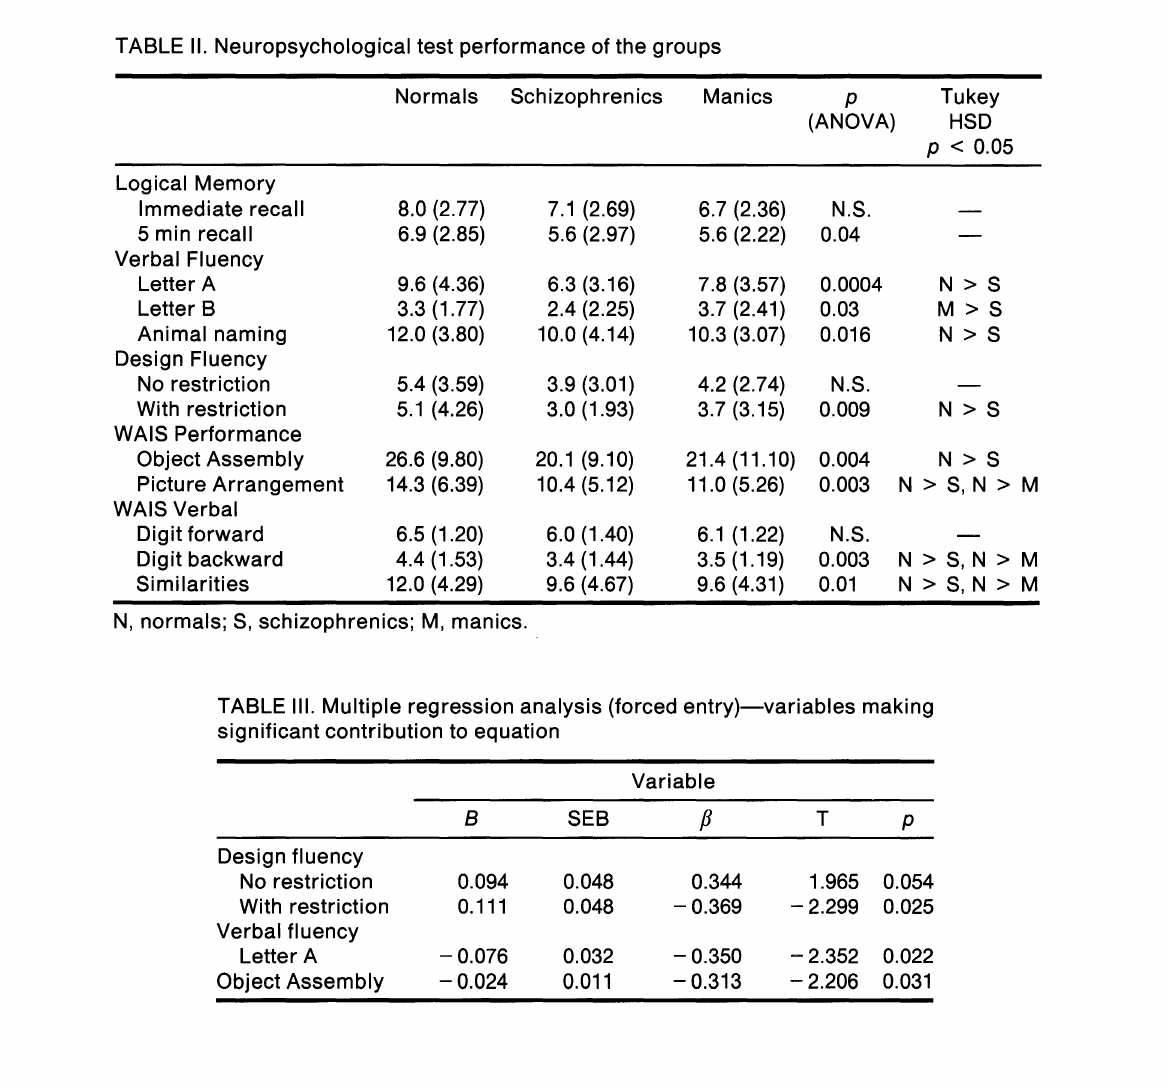
TABLE III. Multiple regression analysis (forced entry)-variables making significant contribution to equation